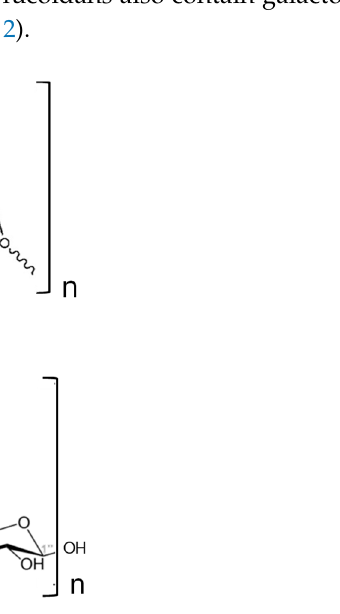
Figure 2. Structure of fucoidans and laminarans present in brown algae.